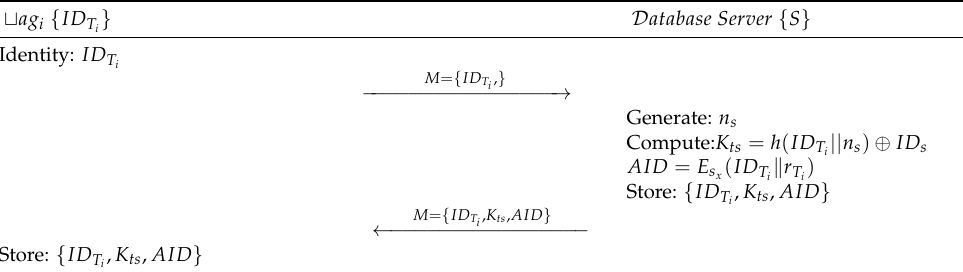
Figure 4. Registration phase of the proposed